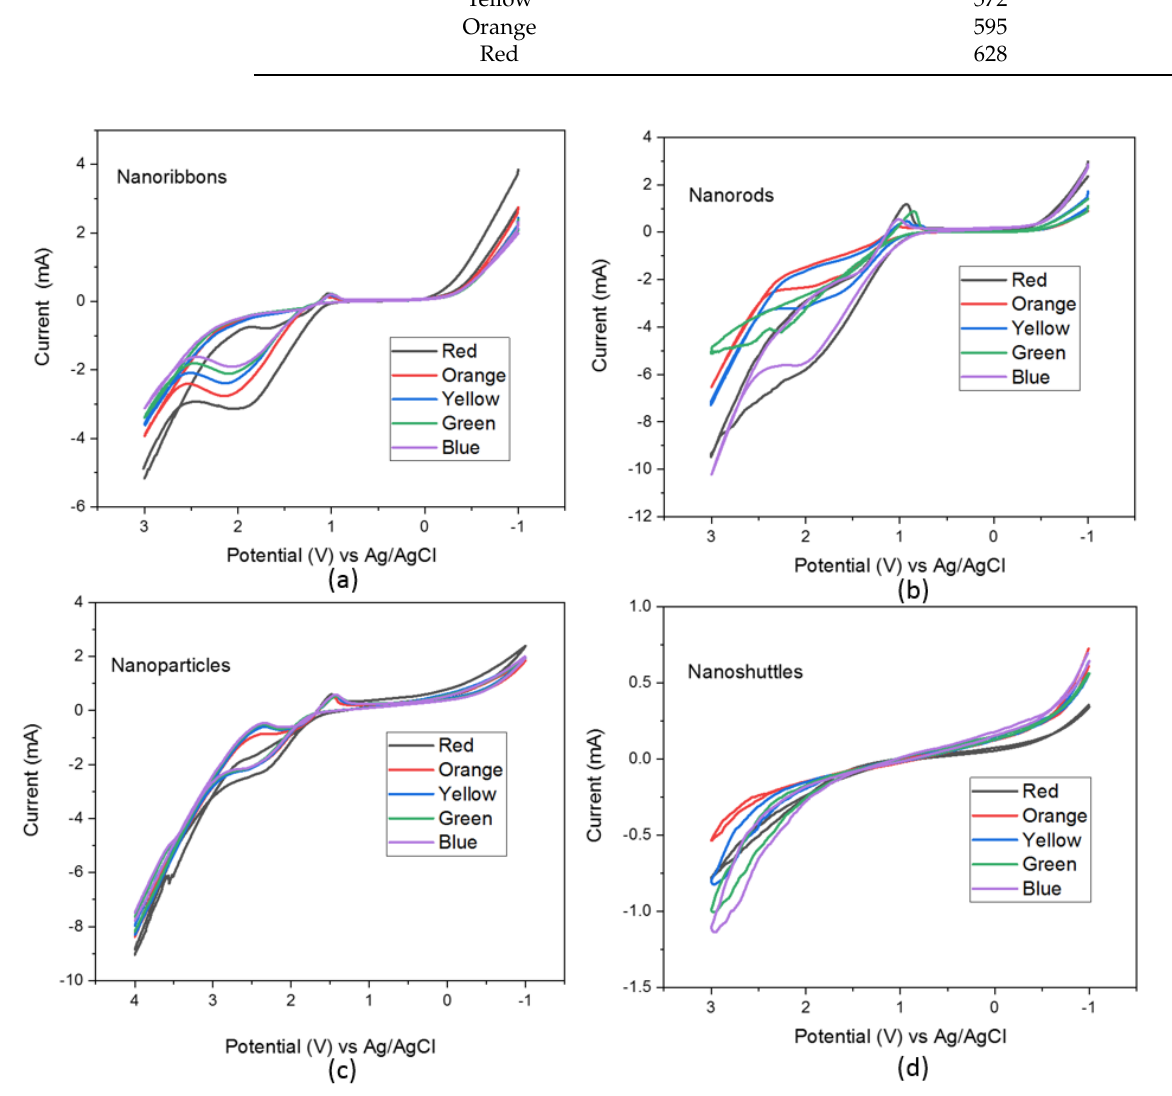
Figure 1. C-V spectra of ZnO nanostructures ( a ) nanoribbons, ( b ) nanorods, ( c ) nanoparticles, and ( d ) nanoshuttles.